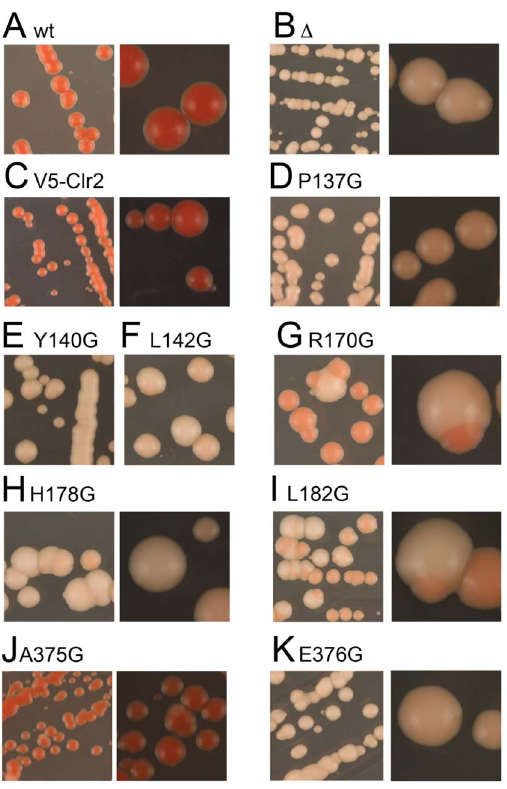
Figure 3. Strains containing the reporter gene mat3-M::ade6 + and point mutations in Clr2 have red/white sectored colonies. All the strains carried the mat3-M::ade6 + . (A) PJ1044, the wild-type strain (Clr2), (B) PJ1085, lacking Clr2 ( D ), (C) PJ1335 contains the V5-Clr2, (D) PJ1349 with V5-Clr2P137G, (E) PJ1425 with V5-Clr2Y140G, (F) PJ1424 with V5-Clr2L142G, (G) PJ1347 with V5-Clr2R170G, (H) PJ1361 with V5- Clr2H178G, (I) PJ1362 with V5-Clr2L182G, (J) PJ1363 with V5-Clr2A375G and (K) PJ1353 V5-Clr2E376G.